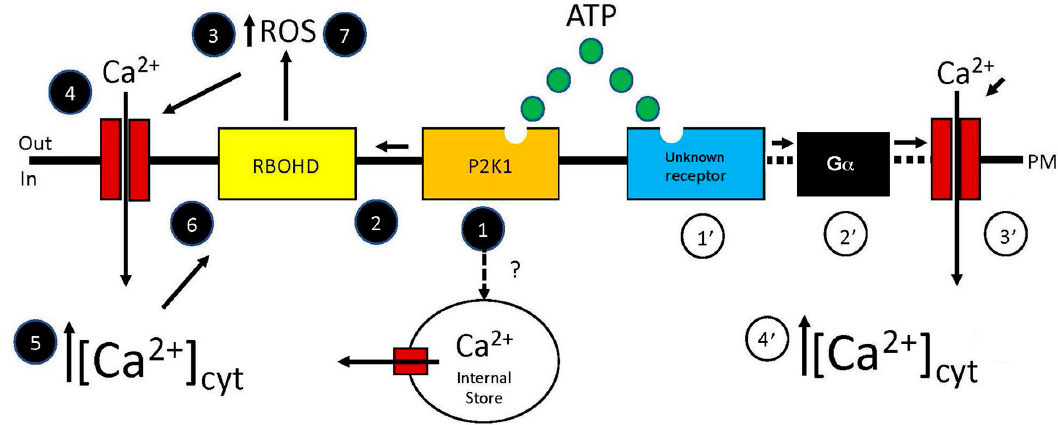
Figure 1. Model of two hypothetical signaling pathways whereby eATP could induce an increase in [Ca 2+ ]cyt. In this model, two potential receptors could initiate the signaling pathway. The one starting with P2K1 is much better documented and supported by published data, whereas the one starting with a postulated (and as yet unknown) receptor is supported only by indirect evidence. The sequence of signaling steps initiated by P2K1 would include: 1, the binding of ATP to the plasma membrane-localized P2K1 receptor, thus activating its protein kinase activity; 2, the receptor-induced phosphorylation and activation of the RBOHD subunit of NADPH oxidase; 3, increased accumulation of reactive oxygen species (ROS) in the extracellular matrix (ECM); 4, ROS-induced opening of calcium channels; 5, increase in the [Ca 2+ ]cyt. This increase could then further activate RBOHD to synthesize more ROS (Steps 6 and 7). The sequence of signaling steps initiated by the postulated unknown receptor would include: 1 ′ , the binding of ATP to the receptor; 2 ′ , activation of G α ; 3 ′ , the direct or indirect induction of Ca 2+ channel activity by G α ; and 4 ′ , increase in the [Ca 2+ ]cyt. There is also evidence for an as-yet unidentified pathway whereby receptor activation leads to the release of Ca 2+ from internal stores, such as vacuoles and mitochondria. Dotted lines indicate steps mediated by as-yet unknown mechanisms.